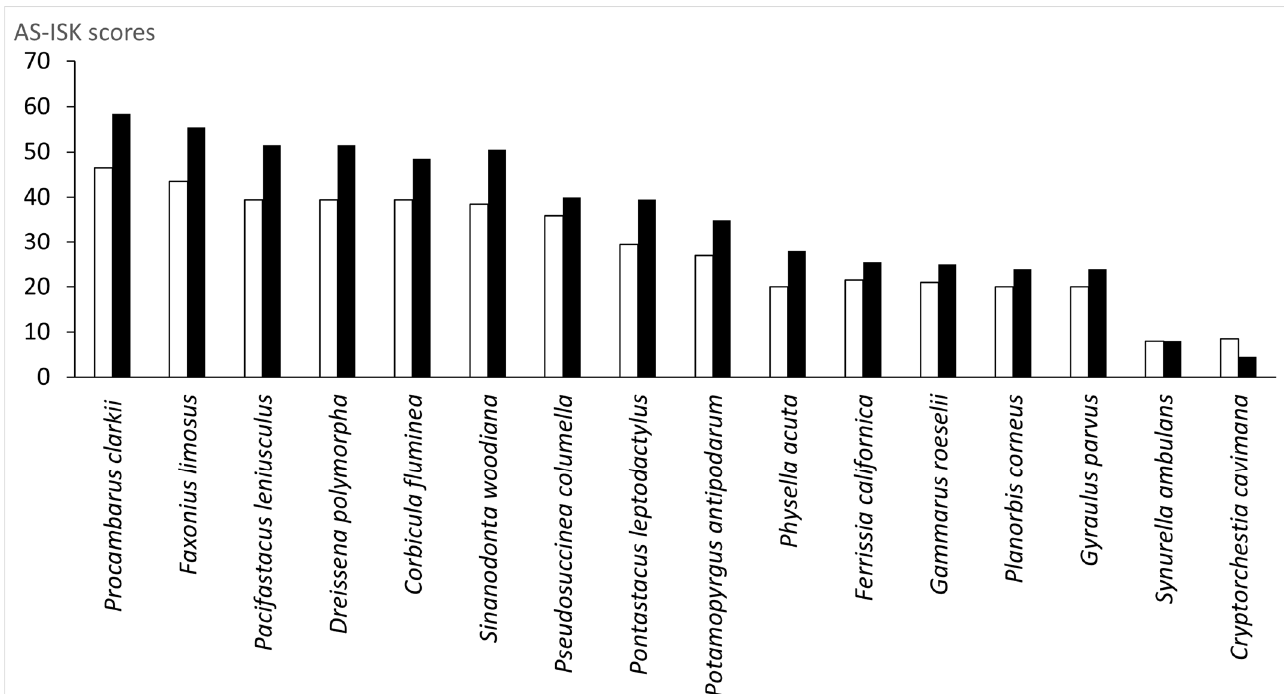
Figure 2. Evaluation of the potential level of invasiveness of the alien species in the assessment area. White columns: Basic Risk Assessment score (BRA); black columns: Basic Risk Assessment and Climate Change Assessment score (BRA + CCA). Table 3. AS-ISK results. AS-ISK sector affected and score partition and level of confidence for each alien species. +: low level of risk; ++: medium level of risk; +++: high level of risk; ++++: very high level of risk. Scenario I uses the thresholds proposed by Paganelli et al. [18], and scenario II uses the thresholds proposed by Vilizzi et al. [47]. AS-ISK Sector Affected Score Partition Level of Risk Scenario I Level of Risk Scenario II Level of Confidence